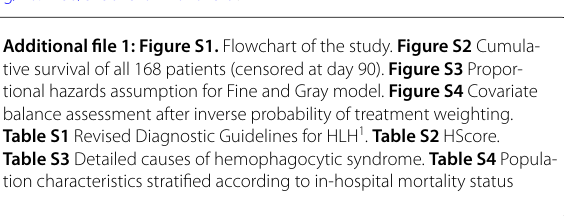
Table S1 Revised Diagnostic Guidelines for HLH 1 . Table S2 HScore. Table S3 Detailed causes of hemophagocytic syndrome. Table S4 Popula- tion characteristics stratified according to in-hospital mortality status